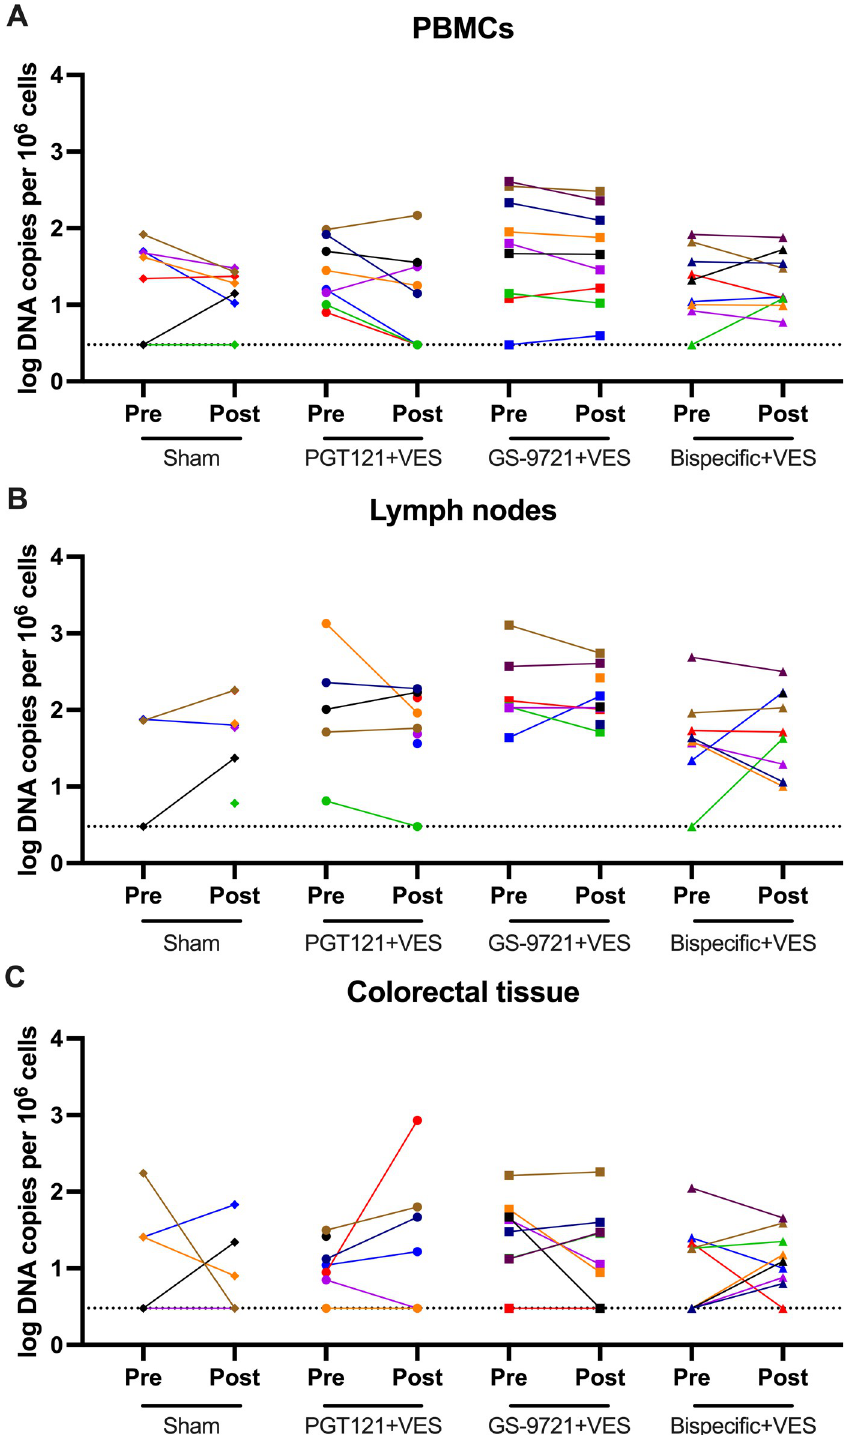
Fig 3. Viral DNA before discontinuation of ART. Total viral DNA in (A) PBMCs, (B) lymph nodes and (C) colorectal tissue were determined by qPCR pre (week -8) and post antibody/VES treatment (week 32). P values calculated using two-sided Mann-Whitney tests. ns, not significant (P > 0.05). Dotted lines indicate limit of detection, values on the line were below limit of detection. Individual symbol and color coding as indicated in S1 Table.